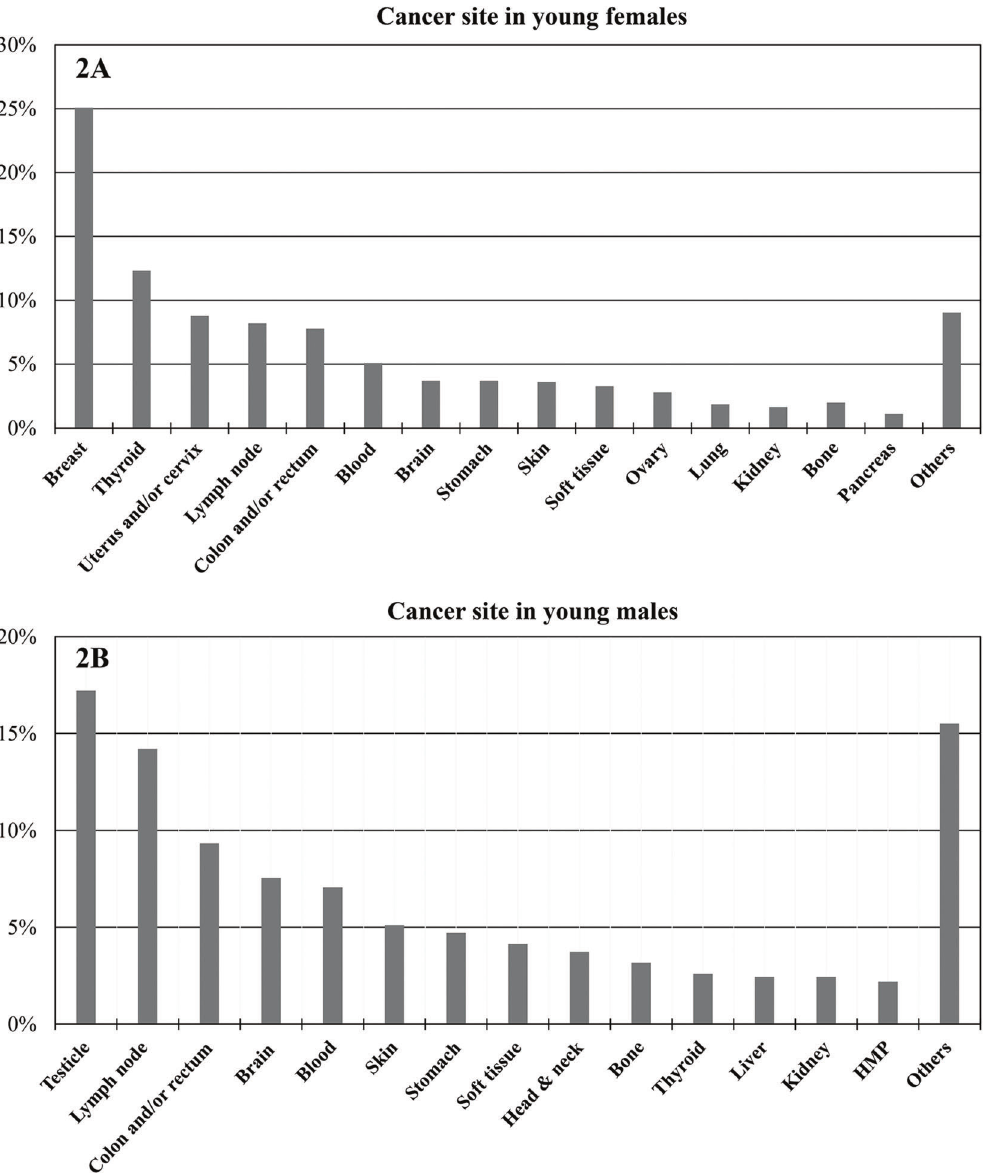
Figure 2 - Cancer sites in young adults stratified by gender (January 2009 to December 2013). (2A) : primary tumor sites (%) in young adult females registered at the ICESP; (2B) : primary tumor sites (%) in young adult males registered at the ICESP. HMP: heart, mediastinum and